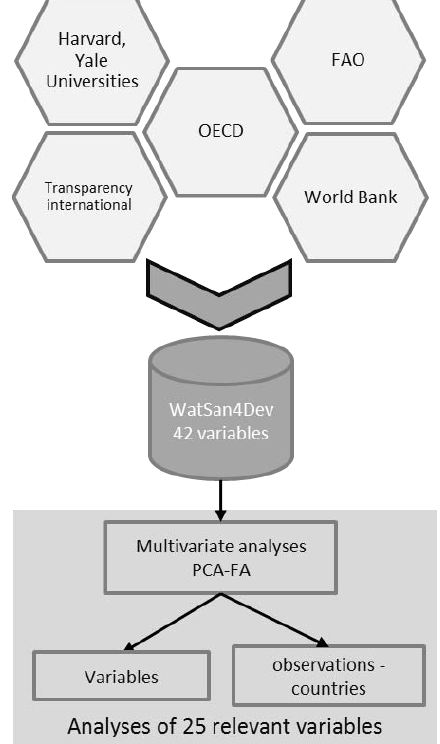
Fig. 1. Approach followed that provides two main results: (1) the identification of key variables impacting the level of WSS services and (2) geographical analysis identifying several country